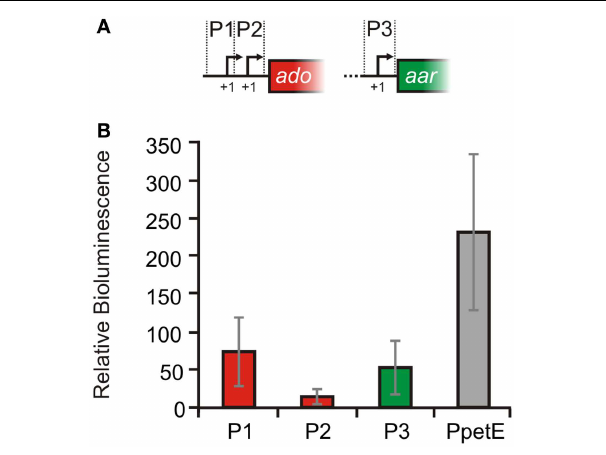
FIGURE 4 |Verification of promoter activities in Synechocystis sp. PCC 6803 . (A) Schematic illustration of the putative promoter regions. For the reporter assays luxAB genes were fused with the upstream sequences of either: SyR9 ( = P1, − 116 to + 2), ado ( = P2, − 108 to + 106nt) or aar ( = P3, − 401 to + 71nt), and also petE ( = P petE , − 273 to + 81, positive control) while + 1 represents the first transcribed nucleotide. (B) Bioluminescence was measured in vivo as total light counts per second. A strain harboring a promoterless luxAB operon was used as negative control.The cultures were grown in standard BG11. For the P petE activity measurements, however, 2 µ M CuSO 4 was added. Relative bioluminescence was calculated by subtraction of the values obtained from negative control cultures. Data are the mean ± SD of 60 single measurements obtained with two biological replicates ( = independent transformants) in several independent experiments.